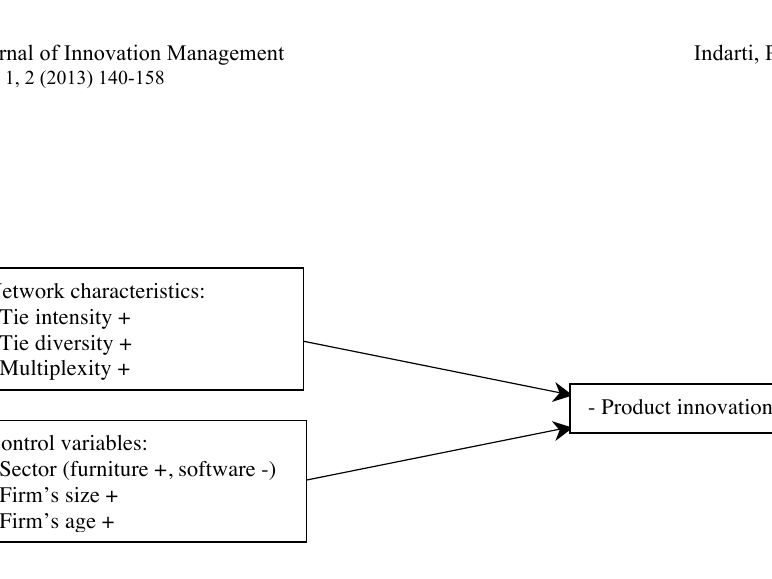
Fig. 2. Conceptual research model (including the